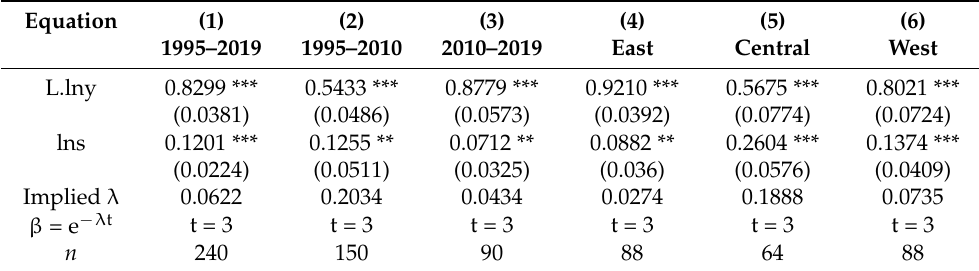
Table 5. Conditional Convergence Test of Dynamic Panel